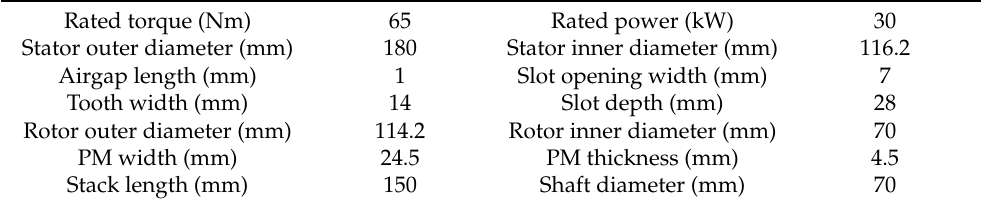
Table 1. Performance and geometric parameters of data of a 12S10P IPM